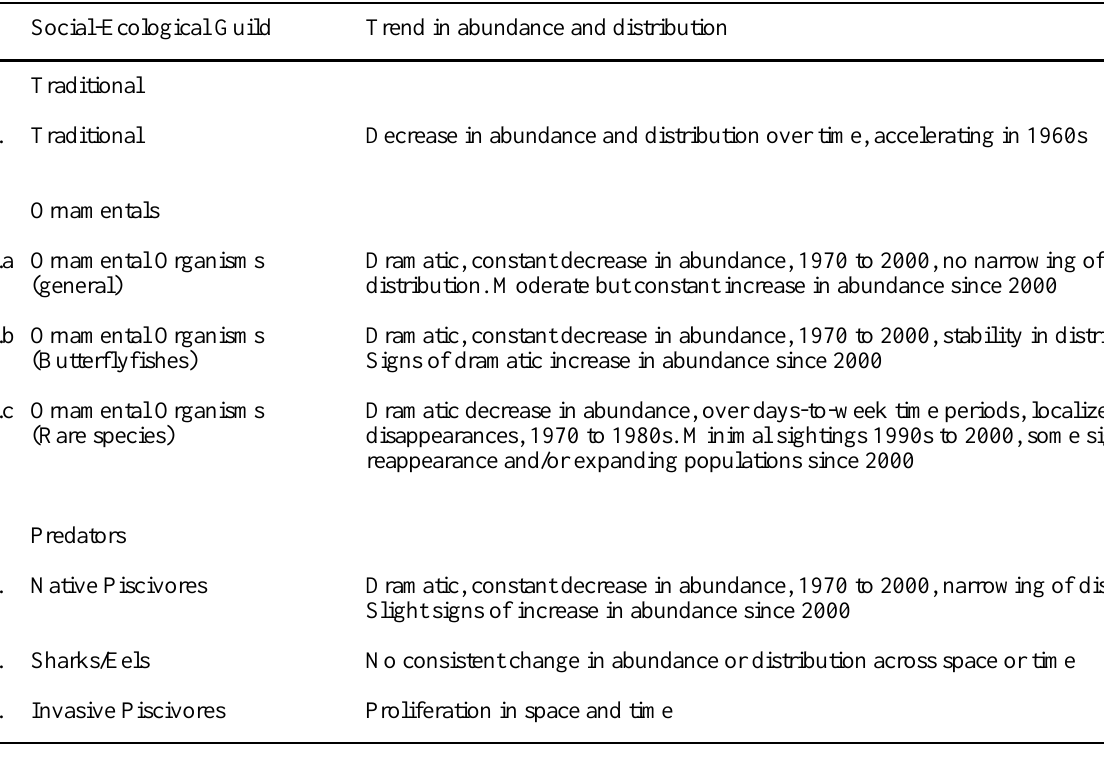
Table 4. Patterns observed across suites of organisms, or social-ecological guilds. All scientific, common, and Hawaiian names of marine organisms are given in Table